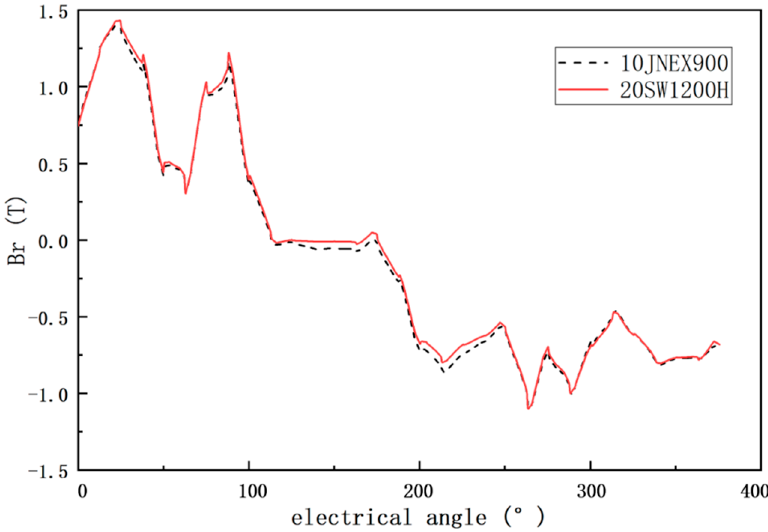
Figure 12. 10JNEX900 and 20SW1200H motor load air-gap flux density comparison.